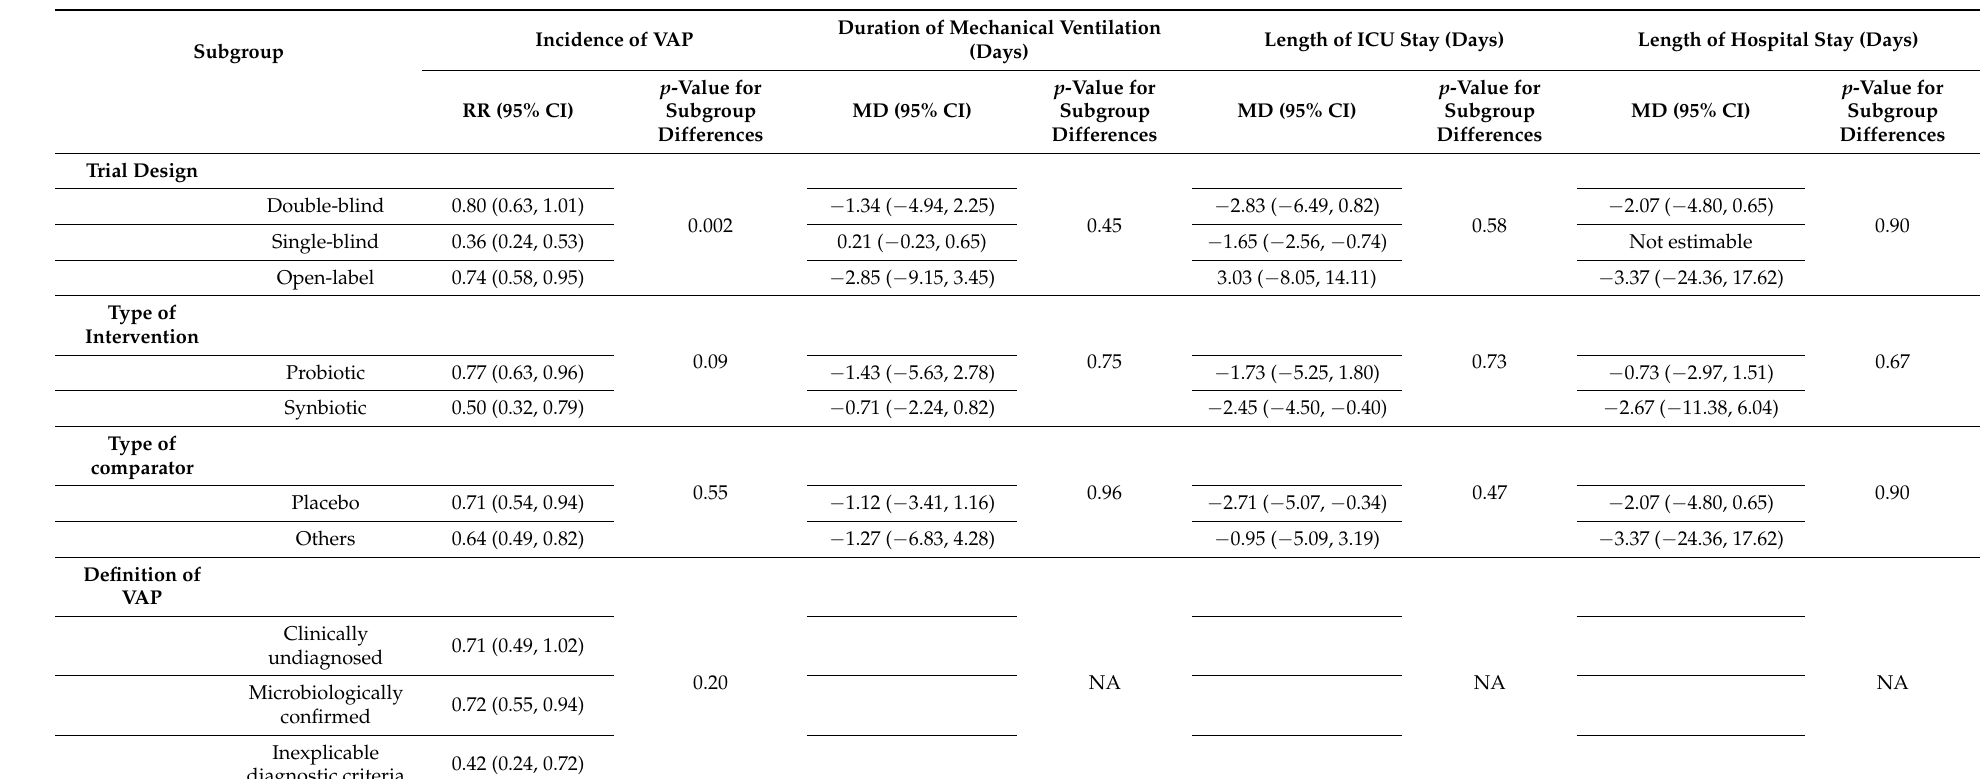
Table 3. Subgroup